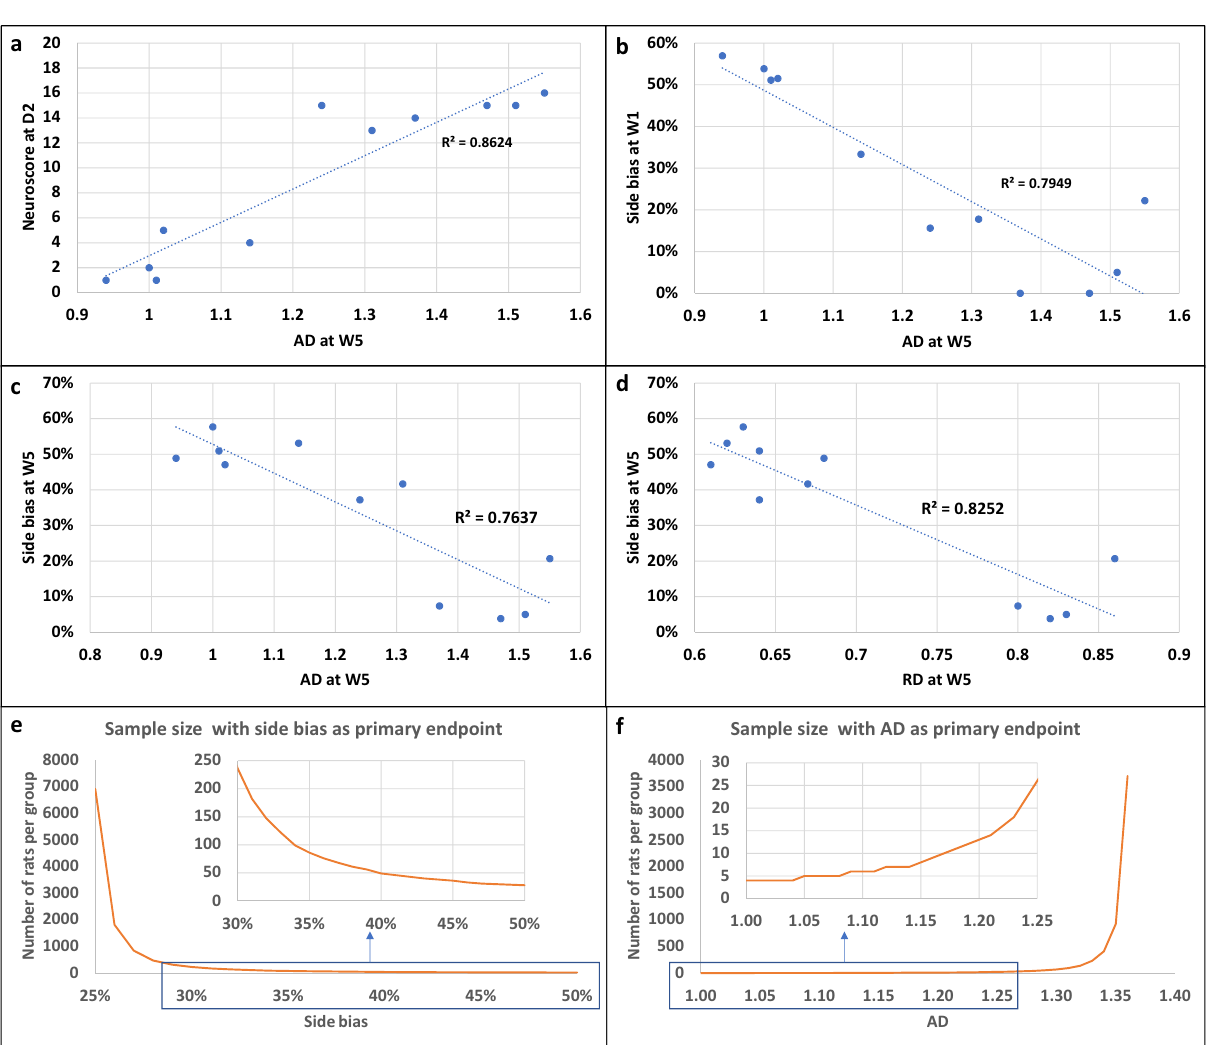
Figure 5. Correlations between neurofunctional and imaging outcomes and sample size calculation. ( a–d ) Main correlations between neurofunctional and imaging readouts. ( a ) Correlation between neuroscores at D2 and AD at D5 (Pearson correlation test, p = 3.65e−05). ( b ) Correlation between side bias at W1 and AD at W5 (Pearson correlation test, p = 0.00022). ( c ) Correlation between side bias at W5 and AD at W5 (Pearson correlation test, p = 0.00034). ( d ) Correlation between side bias at W1 and RD at W5 (Pearson correlation test, p = 6.543e−05). ( e,f ) Sample size calculation for future pre-clinical therapeutic trial. ( e ) Side bias as primary endpoint. The x-axis represents the hypothesized value of side bias in the treatment group and the y-axis represents the corresponding number of rats per group. ( f ) AD as primary endpoint. The x-axis represents the hypothesized value of AD in the treatment group and the y-axis represents the corresponding number of rats per group. AD axial diffusivity, RD radial